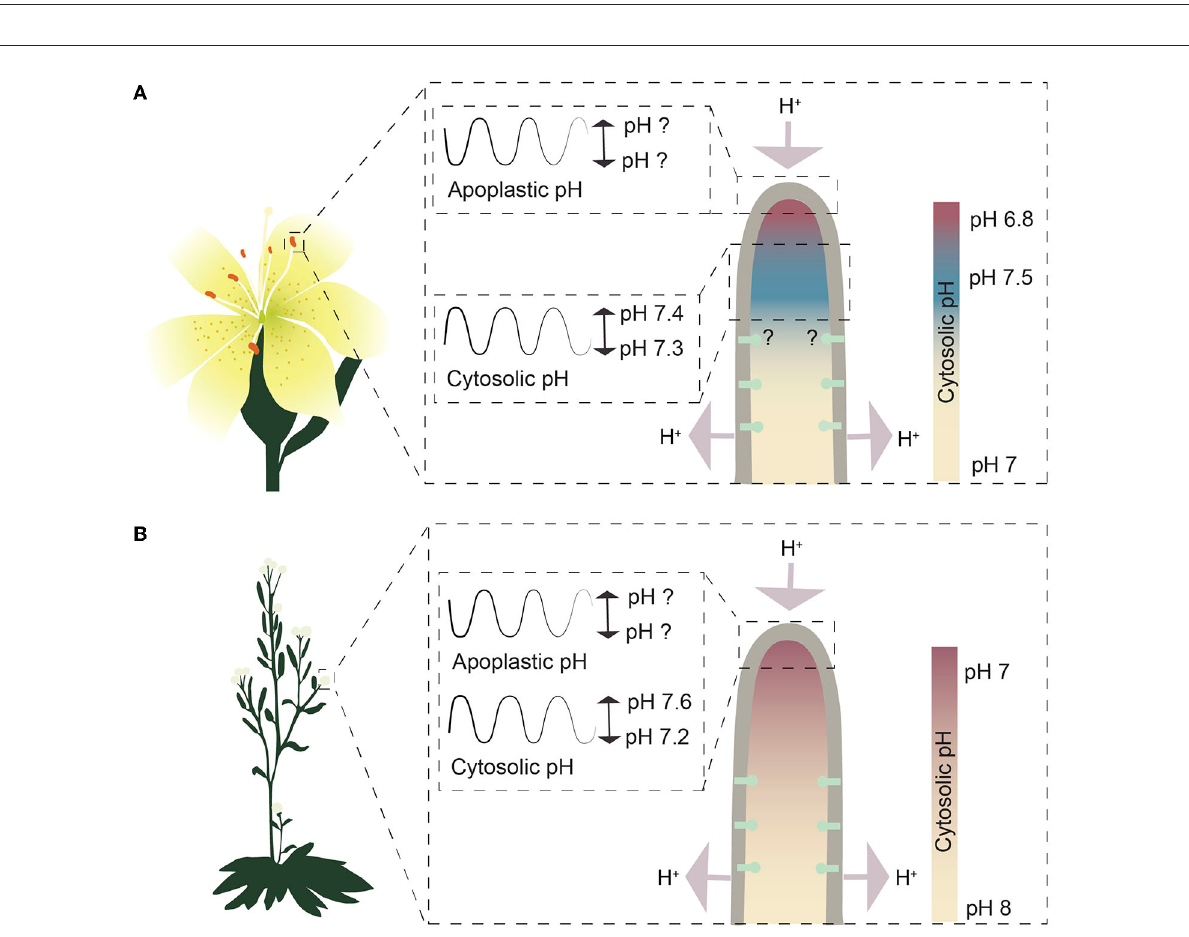
FIGURE2 Schematic representation of growing pollen tubes from the pH point of view. (A) The cytosolic pH gradient and pH oscillations in growing Lilium longiflorum pollen tubes. Values for the pH gradient and the cytosolic pH oscillation in the alkaline band are based on measurements in Feijó et al. (1999) . Question marks indicate undetermined pH values or unknown distribution of plasma membrane H + -ATPases. Color codes represent the cytosolic pH gradient, where red indicates slightly more acidic pH and blue more alkaline pH compared to the rest of the cytoplasm. (B) The cytosolic pH gradient and pH oscillations in growing Arabidopsis pollen tubes. Values for the pH gradient and the cytosolic pH oscillation are based on Hoffmann et al. (2020). Red indicates a more acidic pH, while blue indicates a more alkaline pH. Question marks indicate undetermined pH